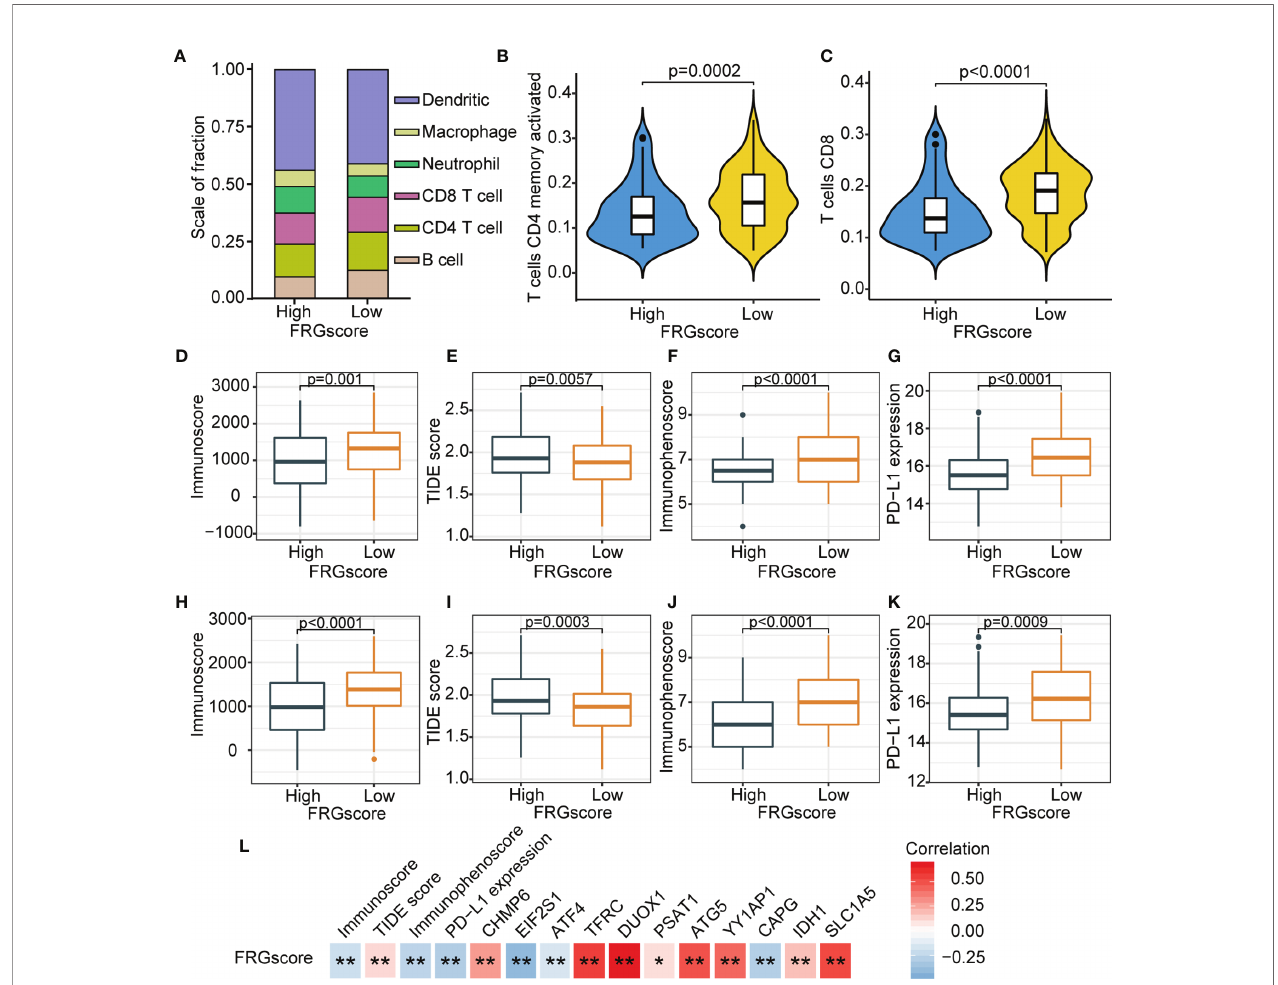
FIGURE 6 | Immune landscape based on FRGscore in early-stage LUAD. (A) Composition of in fi ltrating immune cells in FRGscore-high and FRGscore-low subgroups. (B, C) In fi ltration levels of CD4 memory-activated T cells (B) and CD8 T cells (C) in FRGscore-high and FRGscore-low subgroups. (D – G) Distributions of immunoscore (D) , TIDE score (E) , immunophenoscore (F) , and PD-L1 expression level (G) in FRGscore-high and FRGscore-low subgroups in TCGA cohort. (H – K) Distributions of immunoscore (H) , TIDE score (I) , immunophenoscore (J) , and PD-L1 expression level (K) in FRGscore-high and FRGscore-low subgroups in GSE31210 cohort. (L) Correlations between FRGscore and immune pro fi les and FRG signatures. * p < 0.05 and ** p < 0.01. FRGscore, ferroptosis-related gene score; LUAD, lung adenocarcinoma; TIDE, Tumor Immune Dysfunction and Exclusion; TCGA, The Cancer Genome